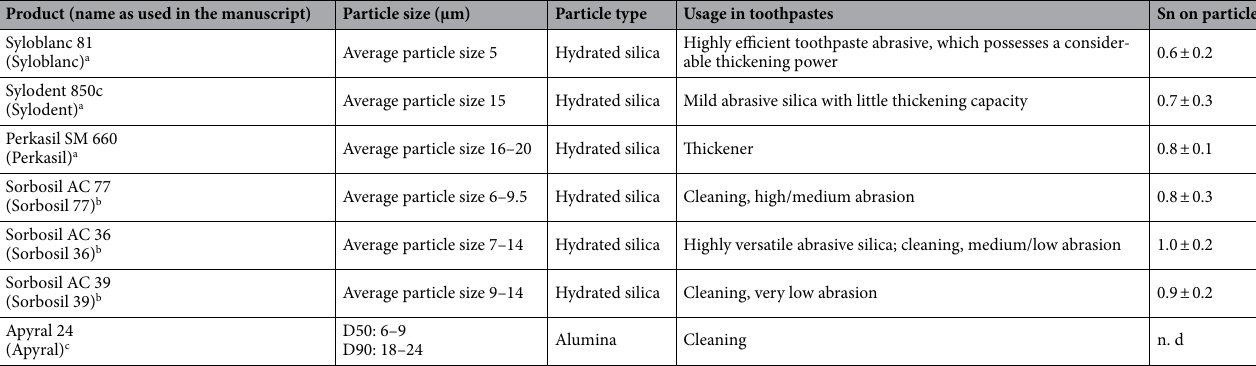
Table 3. Description of the investigated particle types according to the manufacturer’s specifications as well as the amount of tin on the particles after use in F/Sn slurries as determined with EDX in wt % (mean ± SD); n. d.: not detectable; D50: 50% of the particles are smaller than the specified value, D90: 90% of the particles are smaller than the specified value. a Grace, Düren, Germany; b PQ Corporation, Warrington, England; c